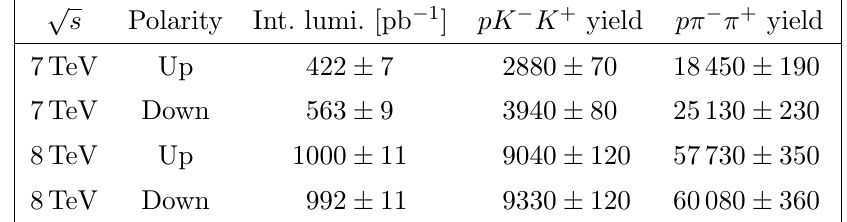
Figure 1 . The ph (cid:0) h + invariant mass spectra from the fully selected (cid:3) + (cid:3) + ! p(cid:25) (cid:0) (cid:25) + (right) datasets summed over all data-taking conditions. The results of the (cid:12)t to each c dataset are shown for illustration. The widths of the signal distributions di(cid:11)er due to the di(cid:11)erent Q -value between the two decays, where the larger value for the (cid:3) + broader shape.